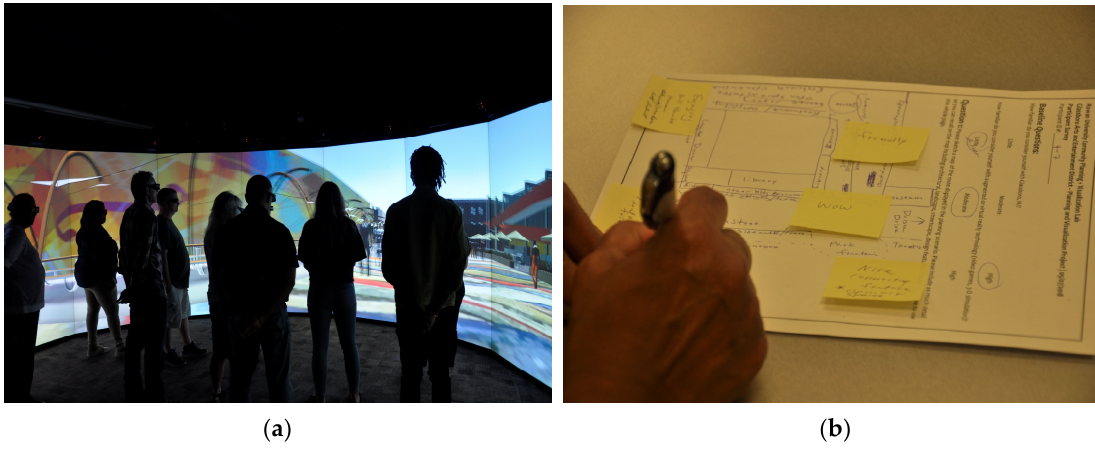
Figure 3. ( a ) Focus group participants experiencing an immersive virtual reality (IVR) simulation in the CAVE lab. ( b ) A participant working on a mental map.